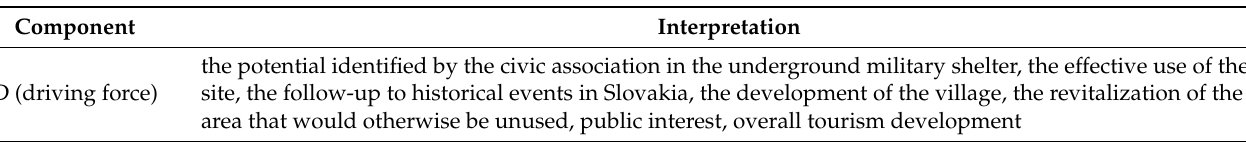
Table 1. DPSIR model for